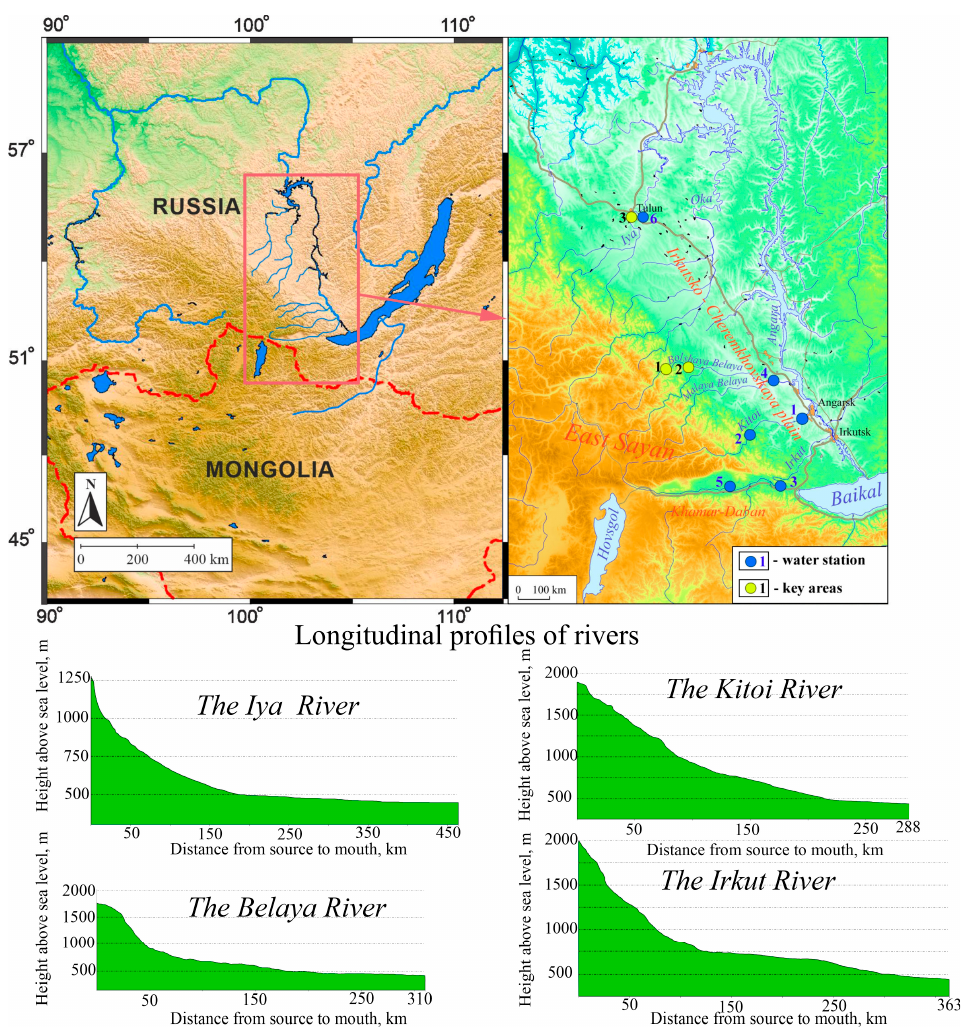
Figure 1. Location of studied rivers and water stations: 1—Kitoi–Kitoi; 2—Kitoi–Dabady; 3—Irkut– Tibel’ti; 4—Belaya–Mishelevka; 5—Irkut–Tunka; 6—Iya–Tulun. Key areas: 1—Novostroika, 2—Bolshebel’sk, 3—Tulun.